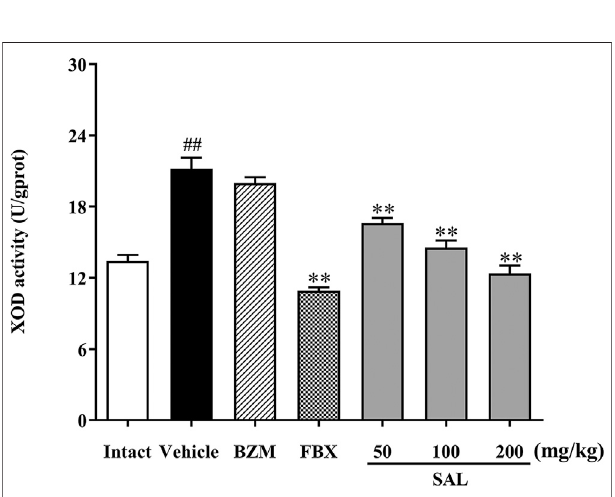
FIGURE 4 | Effect of SAL on the activity of XOD in liver. All data are expressed asmean ± SD( n (cid:2) 8). ## p < 0.01vs.theintactgroup, **p < 0.01vs. the vehicle